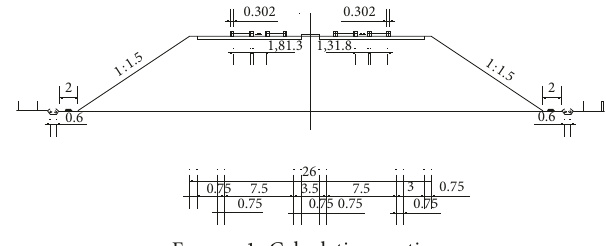
Figure 1: Calculation Figure 2. The total height of the embankment is 8 m, and the slope is 1 :1.5. The width of the embankment is 25 m, and the width of the upper road is 13 m. The foundation is equal to the height of the slope, which is 10 m, and the slope to the right is about 1 time the width of the em-